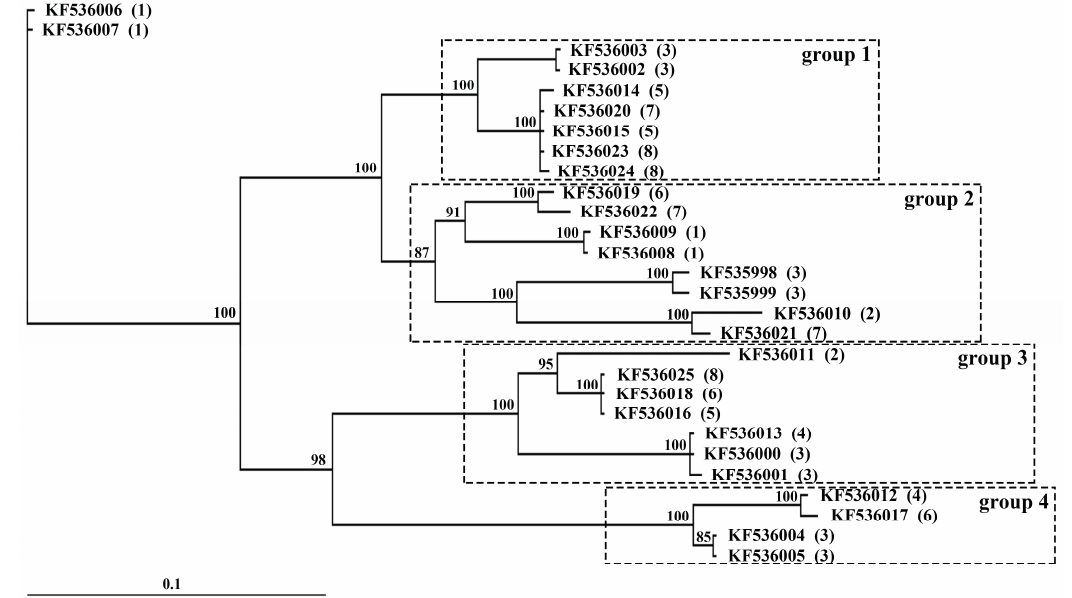
Figure 3. Bayesian inference phylogenetic tree of MHC class II B alleles from eight stone flounder individuals. Sequences are indicated by their Genbank numbers. The individual they are sequenced from are indicated by numbers in parentheses. The sequences are divided into four groups, boxed by dashed